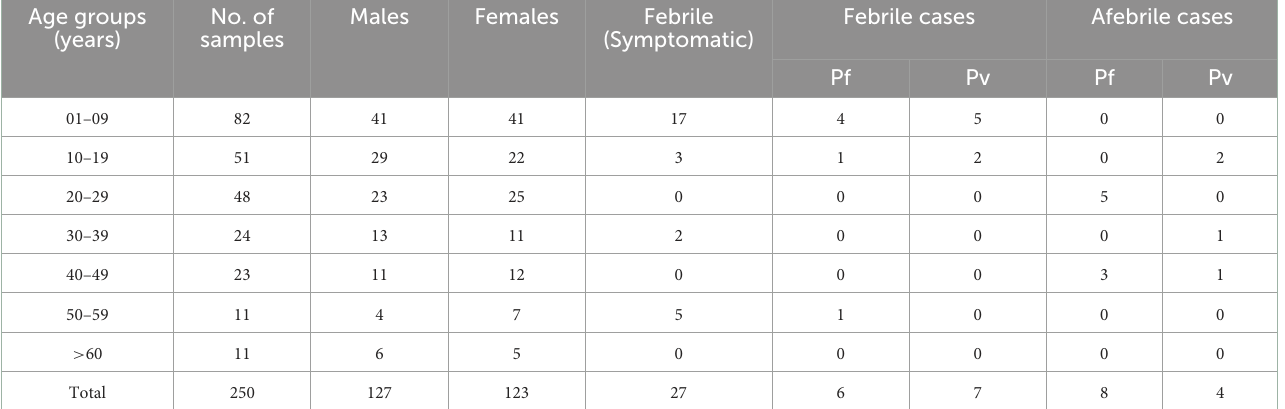
TABLE 2 Age-group wise infections of Pf and Pv in symptomatic/asymptomatic patients. Age groups No. of (years)